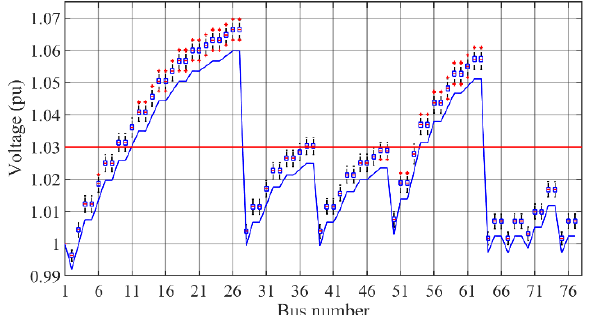
Figure 3. Impacts of considered model uncertainties on nodal voltages (blue line represents the voltages obtained considering the nominal parameters of system components, red line shows the predefined voltage limit, i.e., 1.03 pu, and the boxplots demonstrate the model uncertainty impacts on nodal voltages).